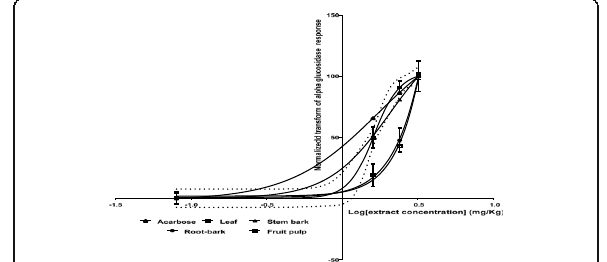
Fig. 9 Dose-response curve of α -glucosidase inhibition by